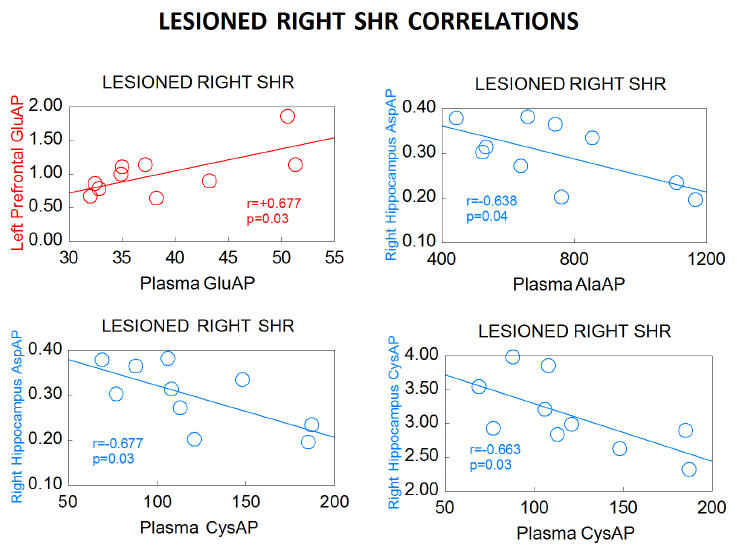
Figure 7. Significant correlations between aminopeptidase activities expressed as nmol of the corre- sponding L-amino acid- β -naphthylamide, hydrolyzed per min per mg of proteins in the left prefrontal cortex (red) or right hippocampus (blue), and plasma aminopeptidase activities, expressed as pmol of the corresponding L-amino acid- β -naphthylamide, hydrolyzed per min per mg of proteins, in lesioned right spontaneously hypertensive rats (SHR) (see Table 4). Negative correlations are in blue. Positive correlations are in red. Pearson’s correlation coefficients (r) and p values are indicated in each